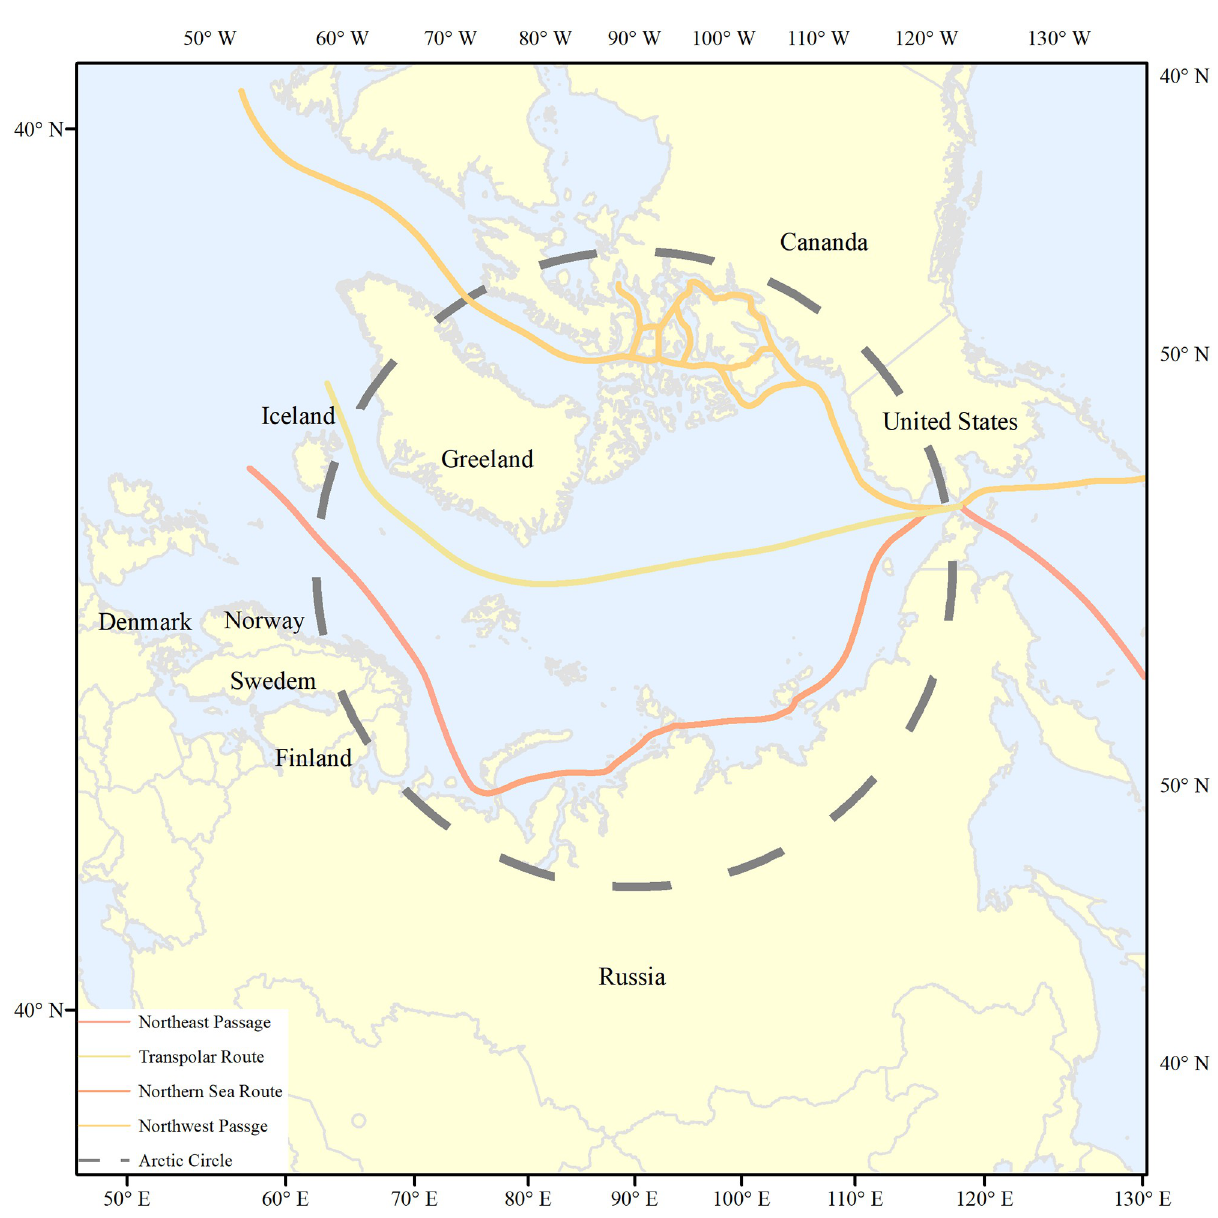
Fig 1. Sketch map of the Arctic Passage. The boundary was obtained from Natural Earth (http://www.naturalearthdata.com/).